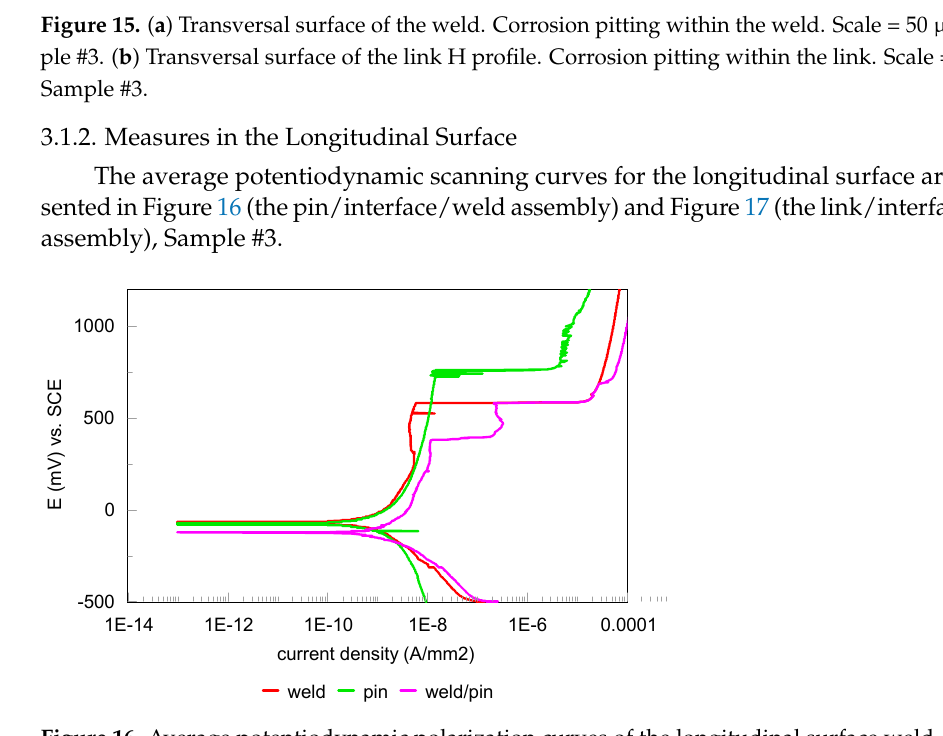
Figure 15. ( a ) Transversal surface of the weld. Corrosion pitting within the weld. Scale = 50 μm, Sample #3. ( b ) Transversal surface of the link H profile. Corrosion pitting within the link. Scale = 50 μm, Sample #3.